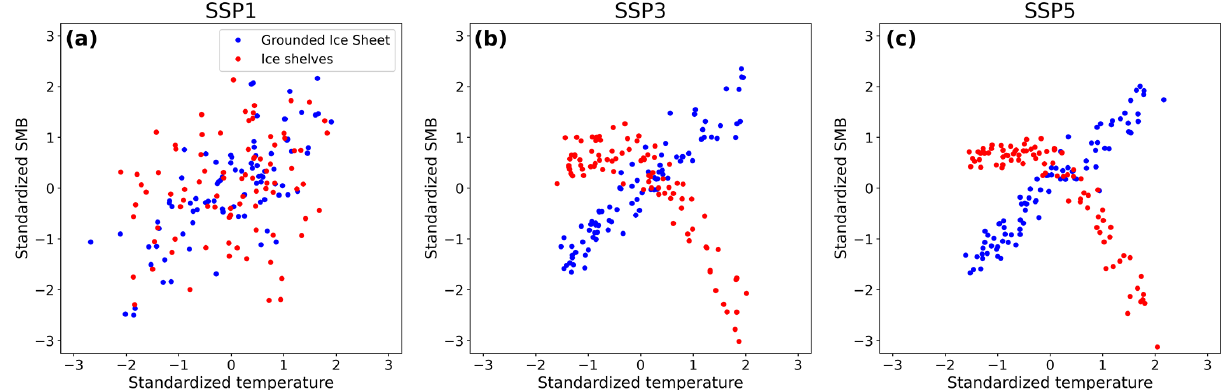
Figure A8. Annual average standardized temperature vs. annual av- erage standardized SMB over ice shelves and the grounded ice sheet for every year from 2015–2100 from (a) SSP1–2.6, (b) SSP3–7.0, and (c) SSP5–8.5.